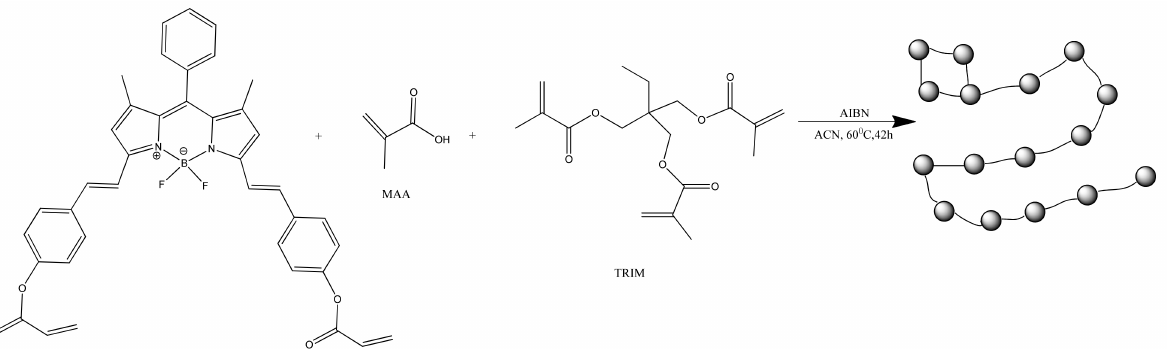
Figure 4. Synthesis of the fluorescent polymer nanoparticles (Reprinted from Hoji, A., et al., Syntheses of BODIPY-incorporated polymer nanoparticles with strong fluorescence and water compatibility. Eur. Polym. J. 2020, with permission from